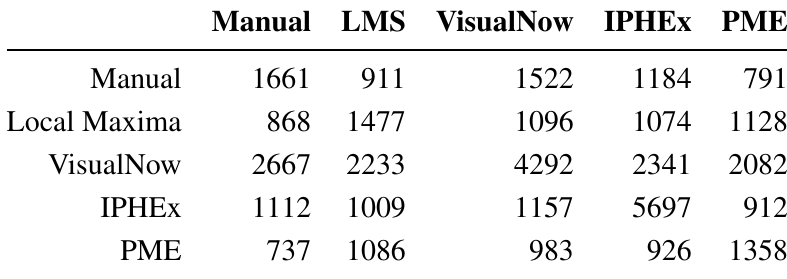
Table 2. Overlap of the five peak detection methods. The overlap of the peak list A (row) and peak list B (column) is defined as the number of peaks in V that can be mapped to at least one peak in W . Note that the resulting mapping count table is not